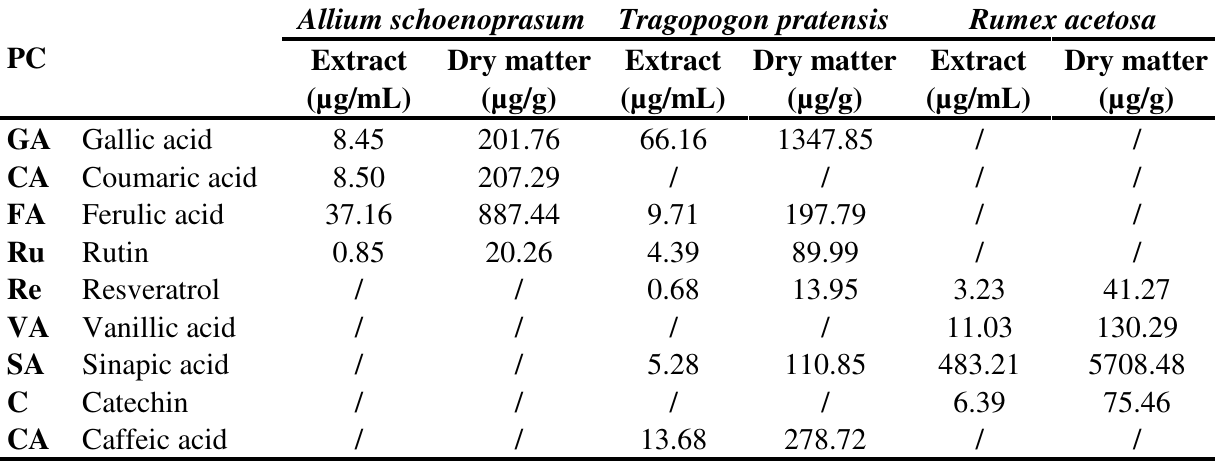
Table 1. Content of phenolic compounds in herbs.